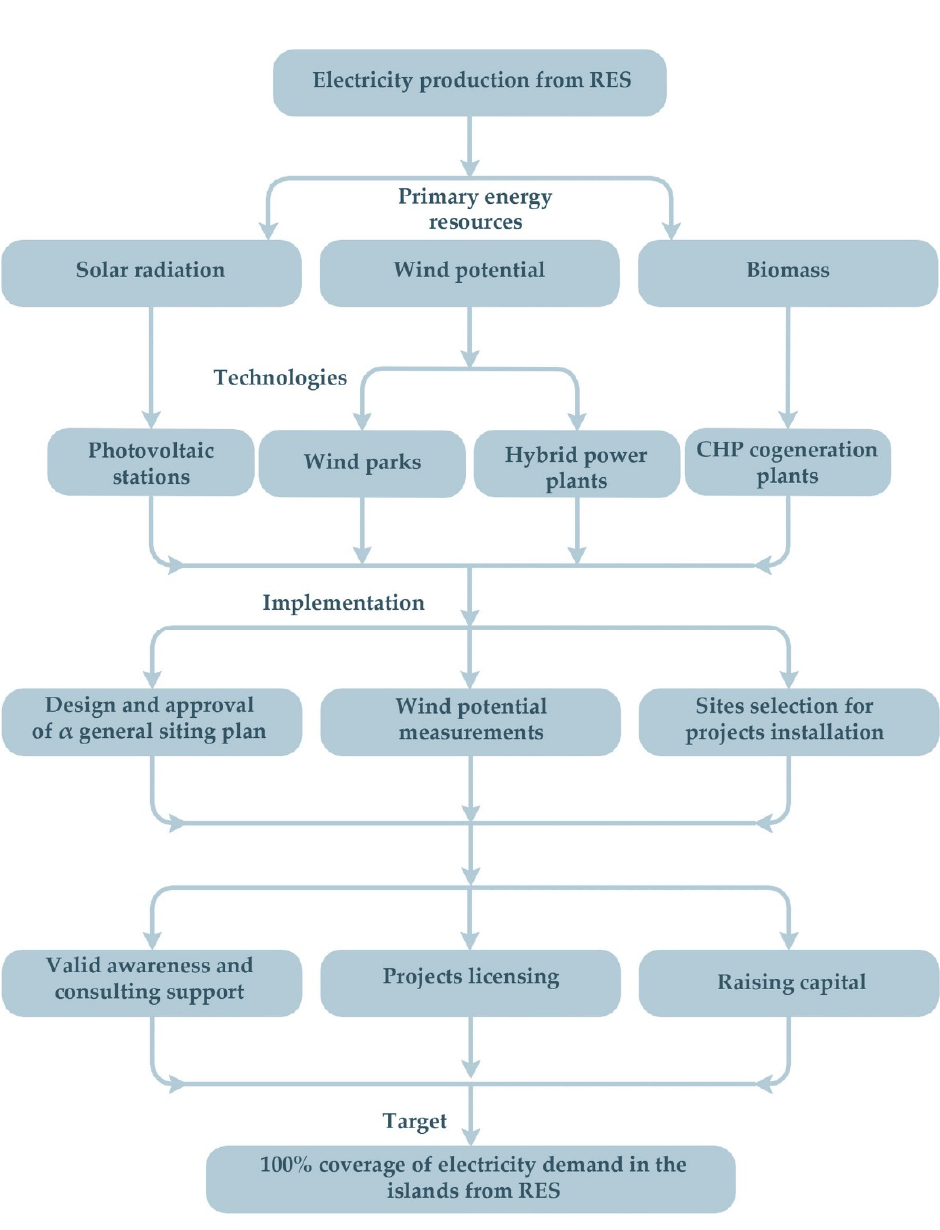
Figure 29. Target and roadmap towards energy transition on electricity production from RES.